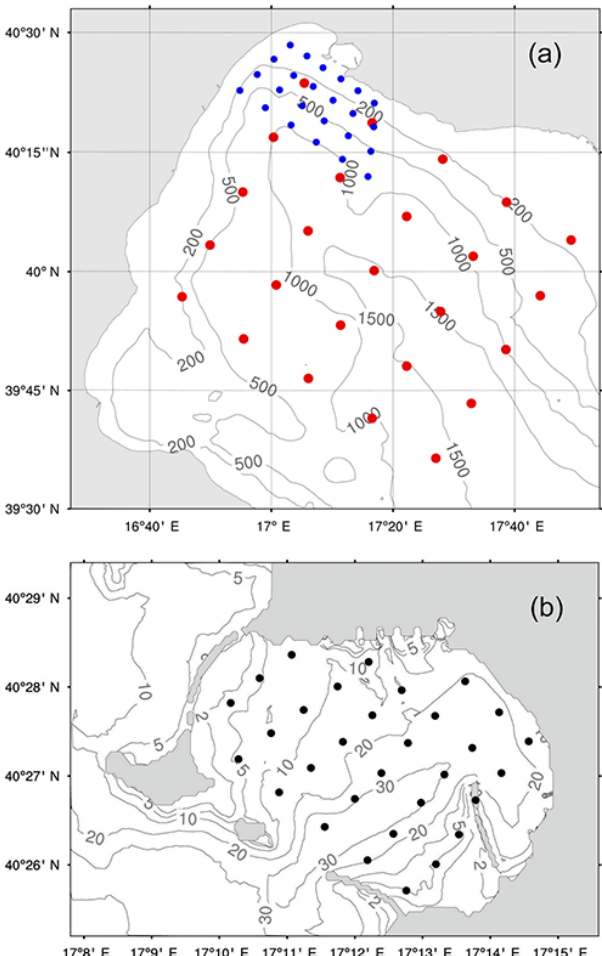
Figure 3. The four survey CTD station distributions: (a) the large- scale survey LS1 and LS2 (red bullets) with the coastal-scale (CS1) survey in the northwestern corner (blue bullets); (b) the Mar Grande (MG)